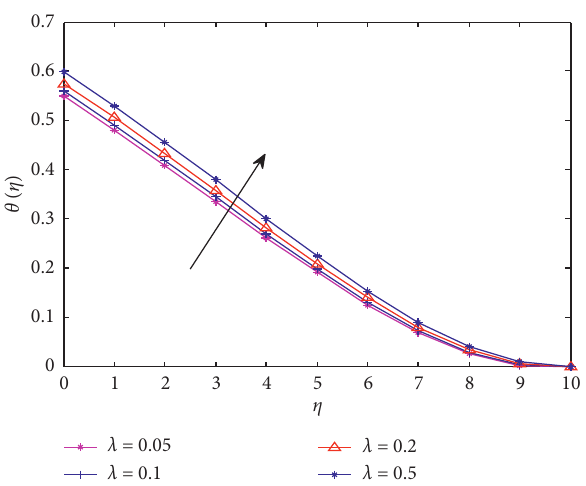
Figure 7: Temperature profiles for various values of internal heat generation ( λ ) when Pr � 0.72, M � 0.1, Gr � 0.1, Ra � 0.1, and Bi � 0.1.